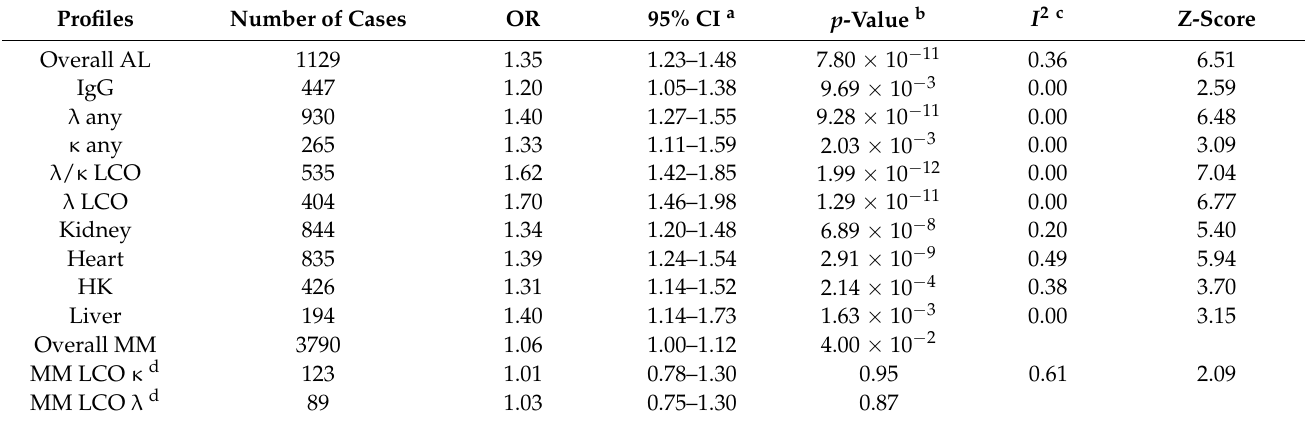
Table 2. Association of risk allele G in SNP rs9344 with light chain only AL (reference [26]).